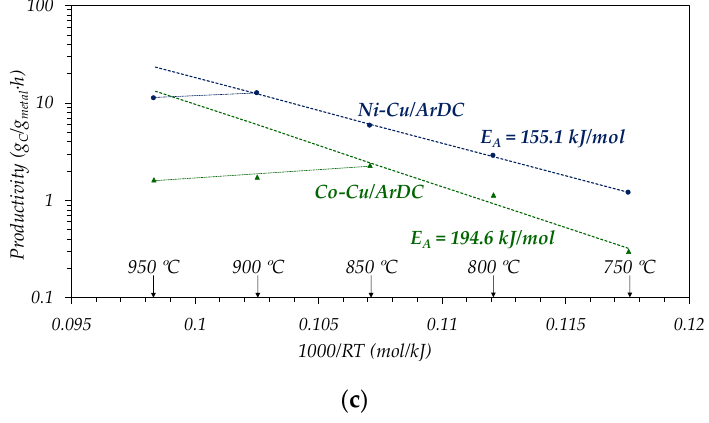
Figure 3. Influence of reaction temperature on evolution of carbon concentration, m C : ( a ) Ni– Cu/ArDC; ( b ) Co–Cu/ArDC; ( c ) Final productivity at 2 h (Dashed line: Arrhenius plot). Table 2. Influence of temperature on the initial reaction rate and carbon productivity*.